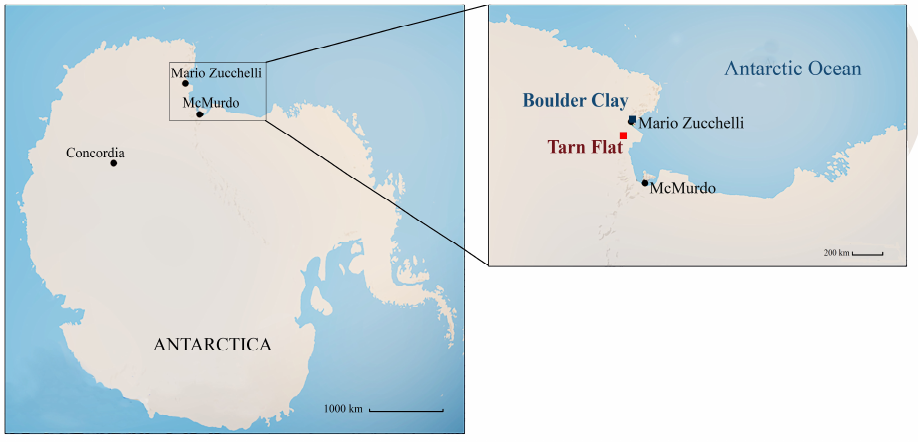
Figure 1. Tarn Flat and Boulder Clay sites in Antarctica.